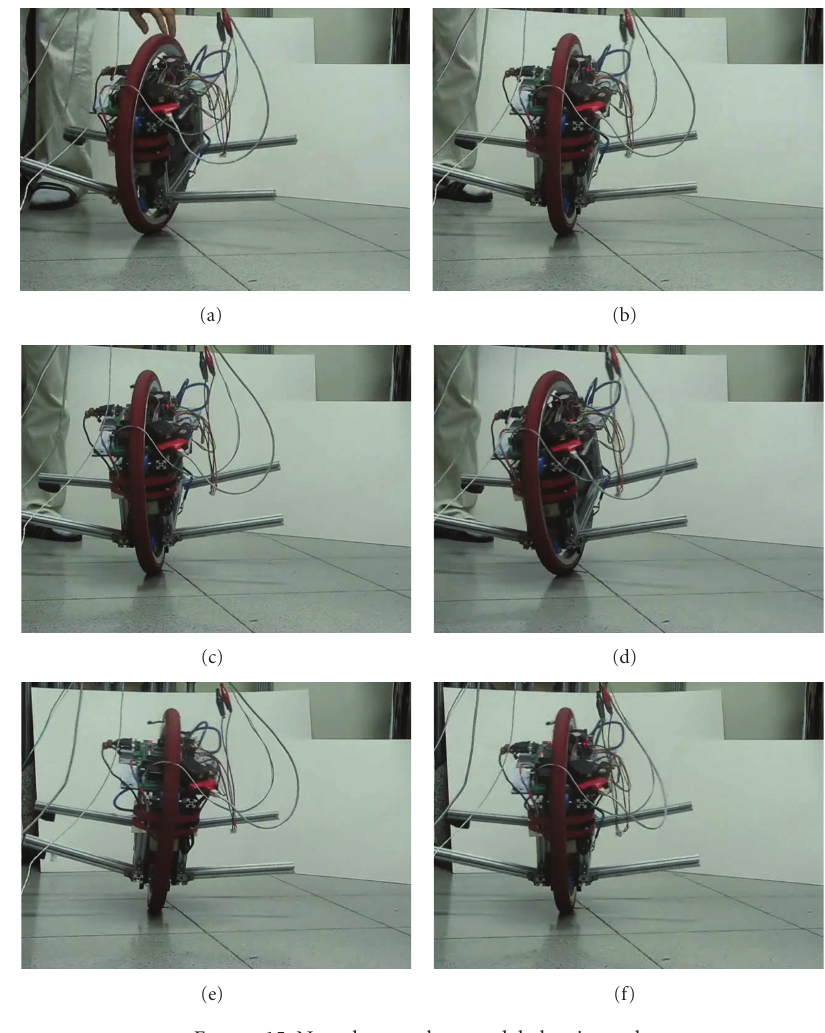
Figure 15: Neural network control: balancing task.